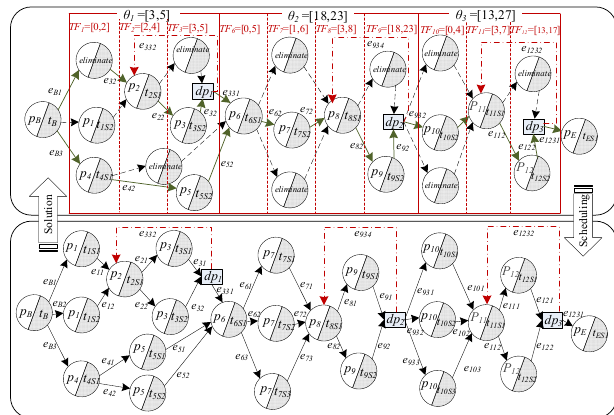
Figure 2. Non-linear production process work- fl ow scheduling process.